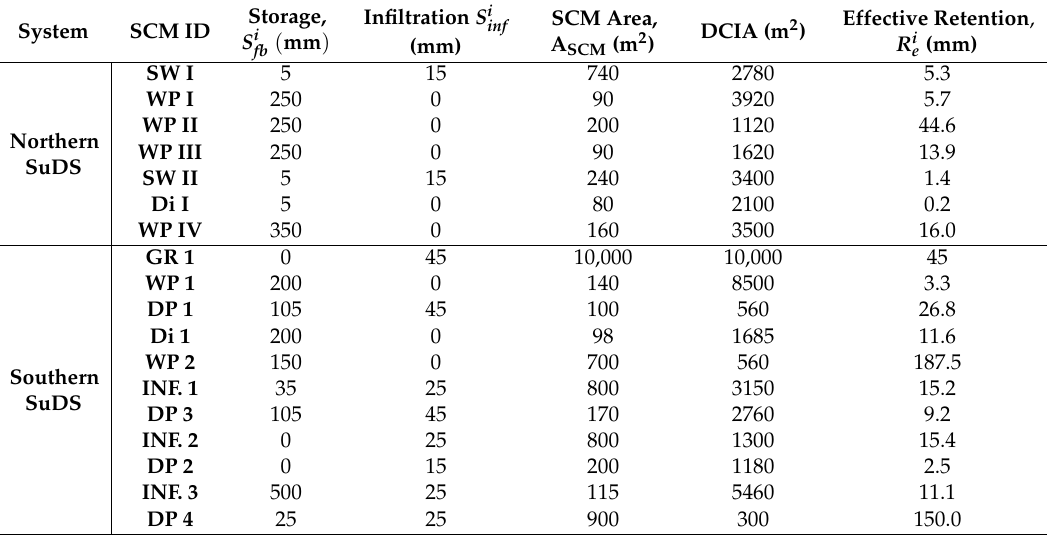
Table 4. Characteristics of the SCMs in the Northern and the Southern SuDS in Augustenborg. The sequence of the SCMs with respect to flow path (upstream-downstream) is illustrated in Figure